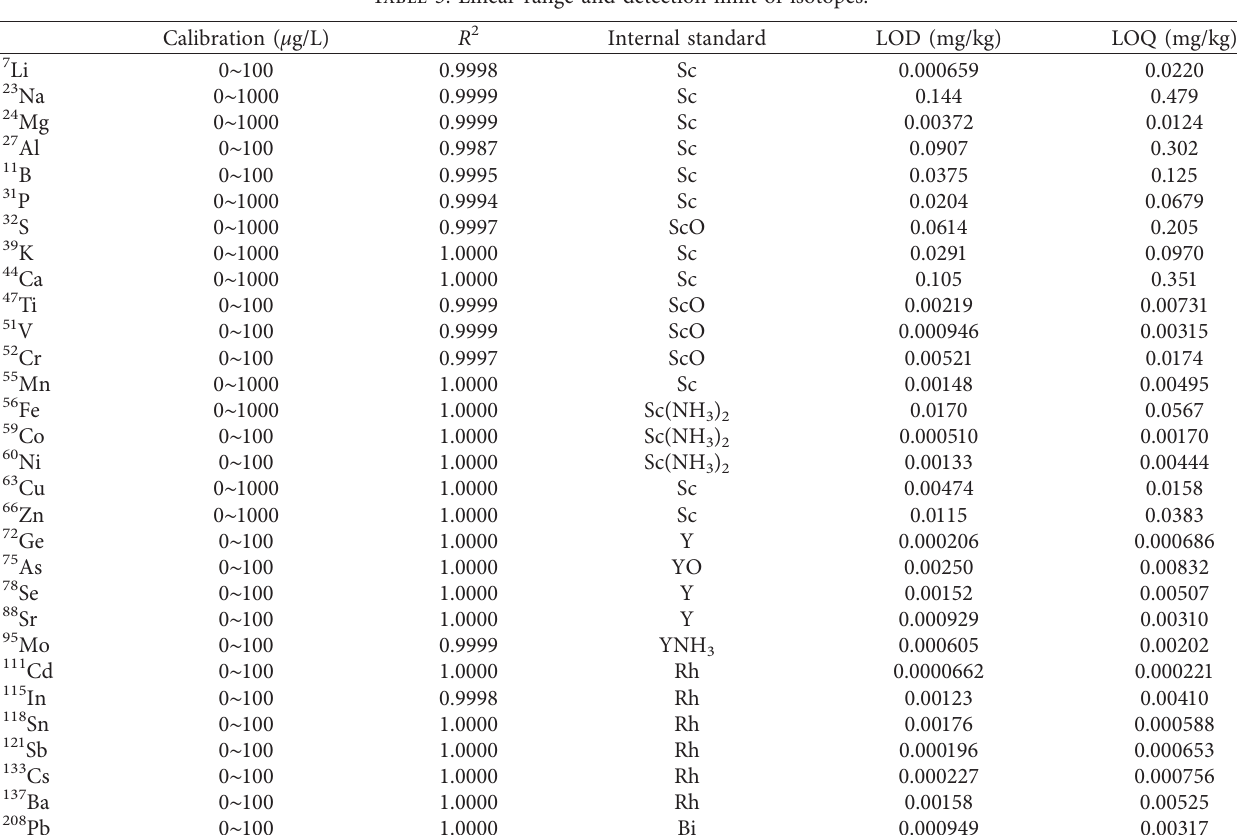
Table 3: Linear range and detection limit of